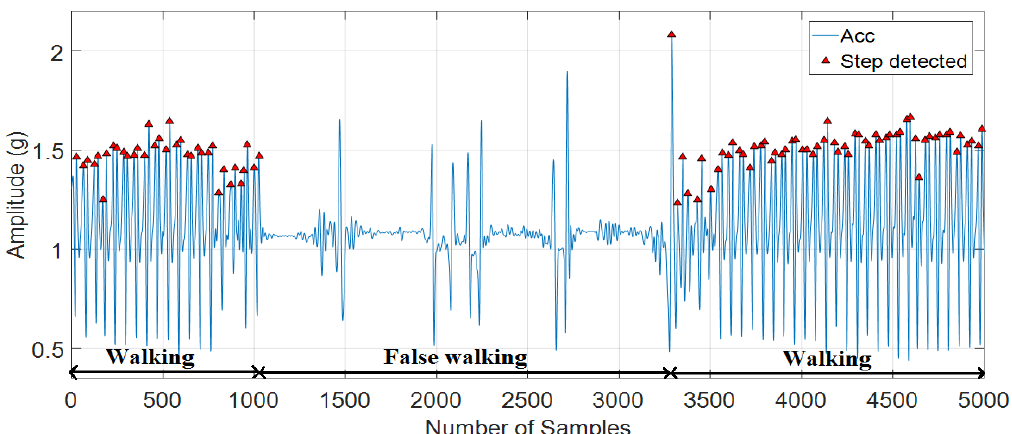
Figure 13. Our proposed algorithm can eliminate false walking while keeping step counting in normal walking.